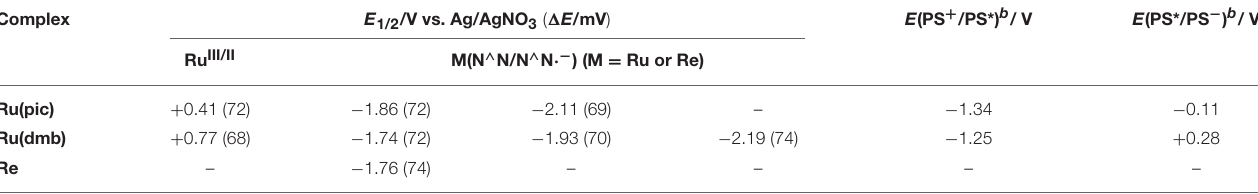
TABLE 2 | Electrochemical properties of the metal complexes in DMA a . Complex